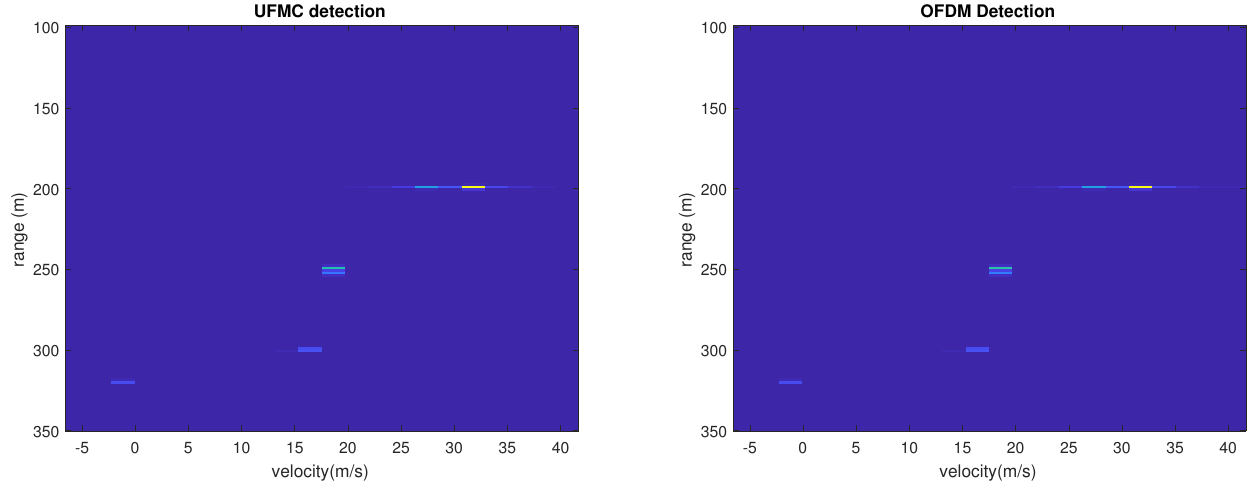
Figure 4. UFMC waveform vs. OFDM waveform.